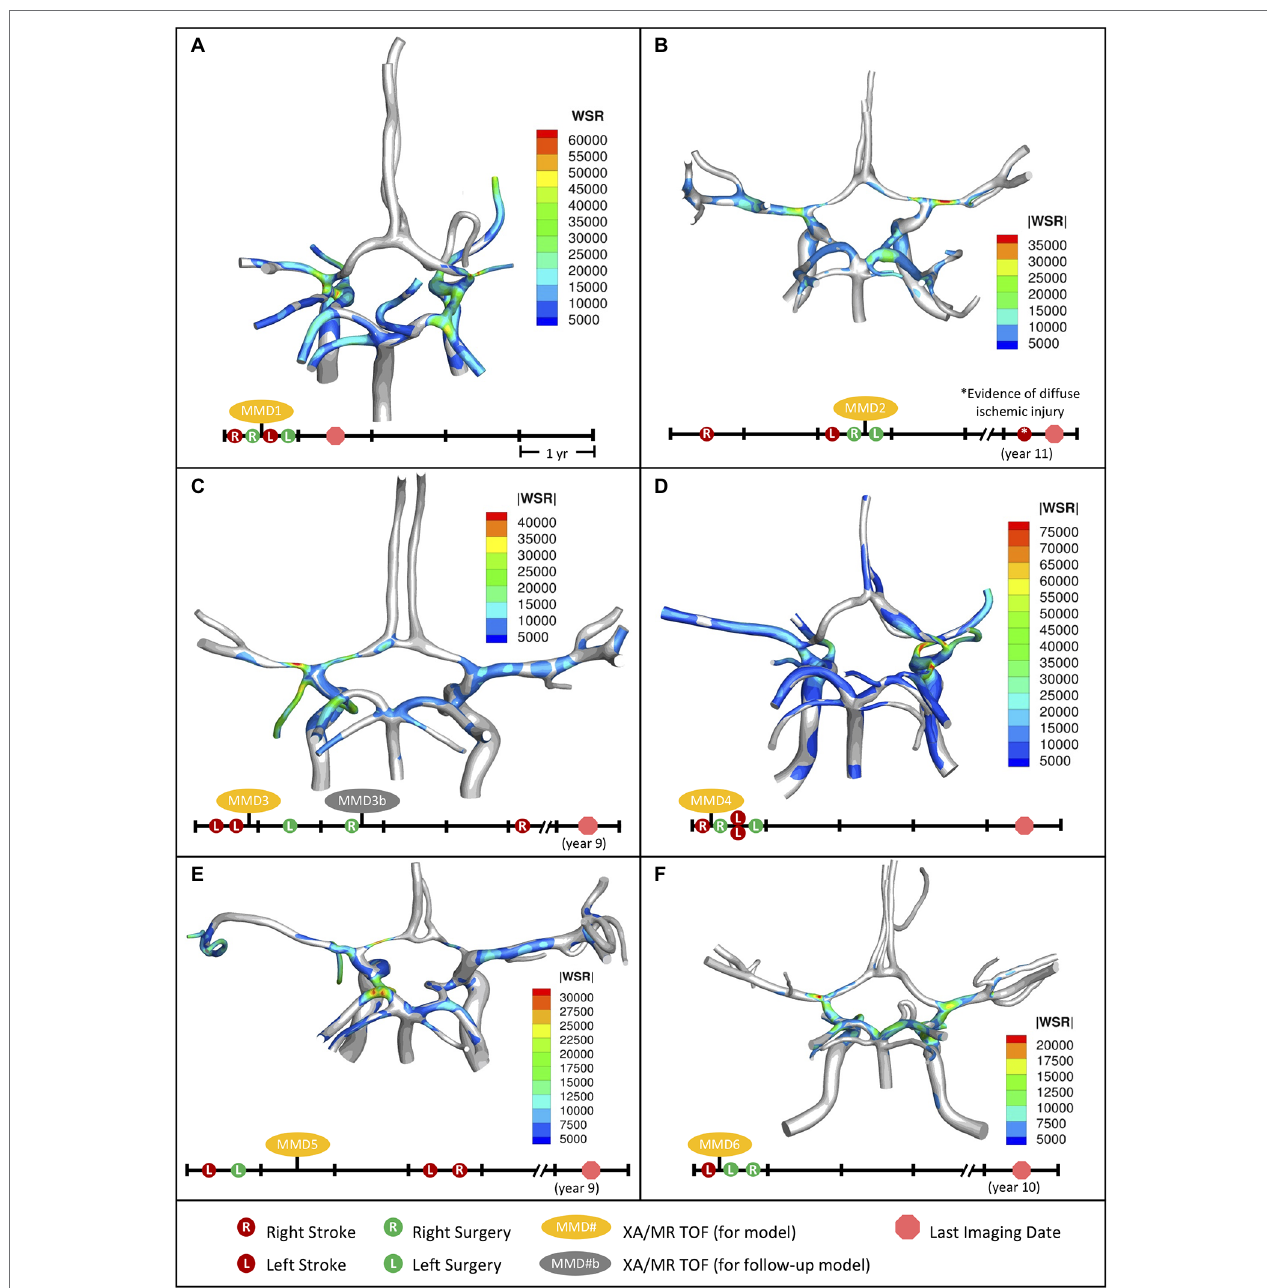
FIGURE 2 | Distribution of WSR above the coagulation limit (>5,000 s − 1 ) at peak systole (top) along with corresponding patient timeline (below) for the patients we studied. (A) MMD1, (B) MMD2, (C) MMD3, (D) MMD4, (E) MMD5, and (F) MMD6. Red circles indicate stroke occurrence, green circles indicate surgery, yellow ovals denote model creation from XA and MR TOF imaging data, and red circle octagon is the last follow-up imaging